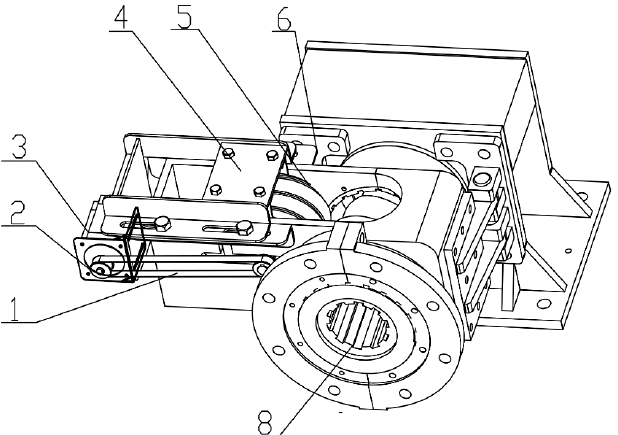
Figure 2. Sketch of the structure of the force-feeding unit. 1. Synchronous belt; 2. Synchronous belt wheel; 3. Three-phase asynchronous motor; 4. Roller fixing frame; 5. Auxiliary roll; 6. Frame; 8. Spindle. 8.